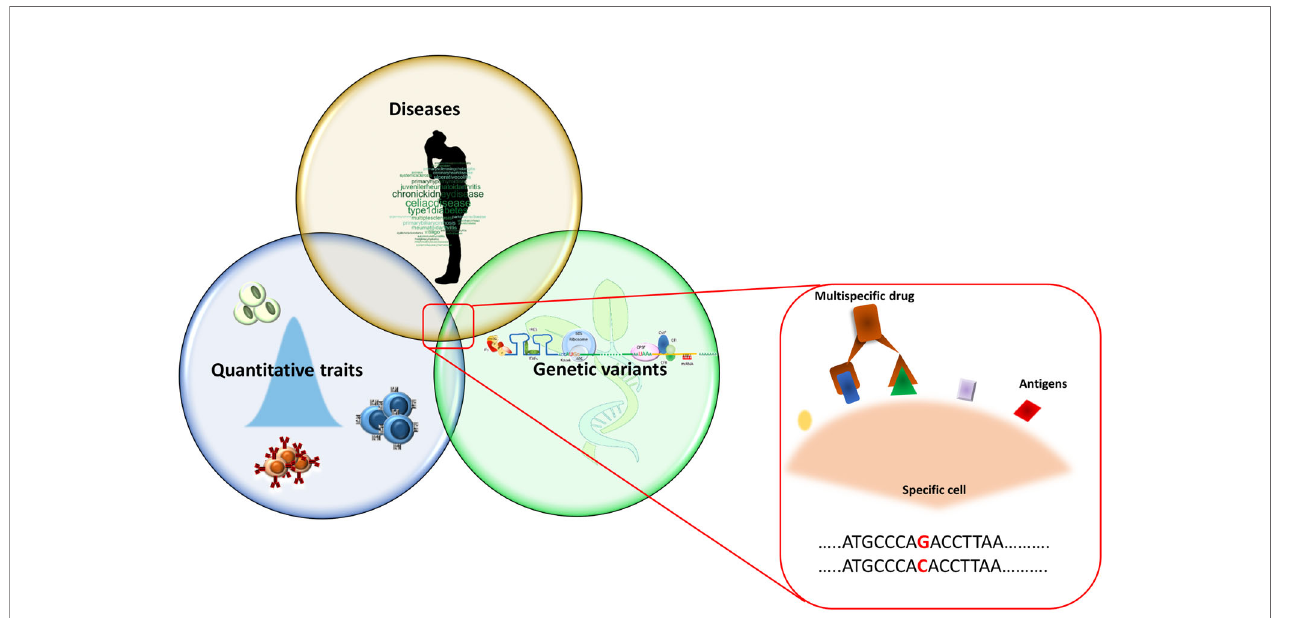
FIGURE 1 | Overview of the study approach. The picture summarizes the research of overlapping genetic associations that initially consists in the identi fi cation of genetic signals regulating immune cells in the general population. These signals are then compared with those associated with diseases with the aim to identify the genetic variants both affecting immune cells and disease risk. The identi fi ed immune cells can be considered as potential drug target on which to act pharmacologically. Being more frequently detectable by more than one antigen expressed simultaneously on their surface, these cells can be targeted by multi- speci fi c drugs (binding two or more speci fi c